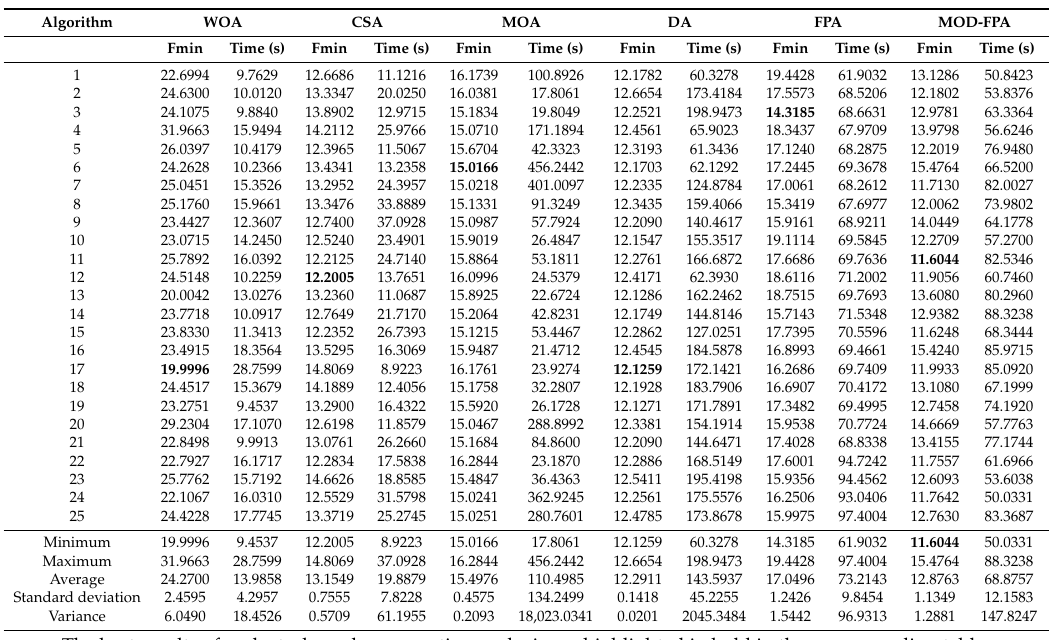
Table 3. Results for each